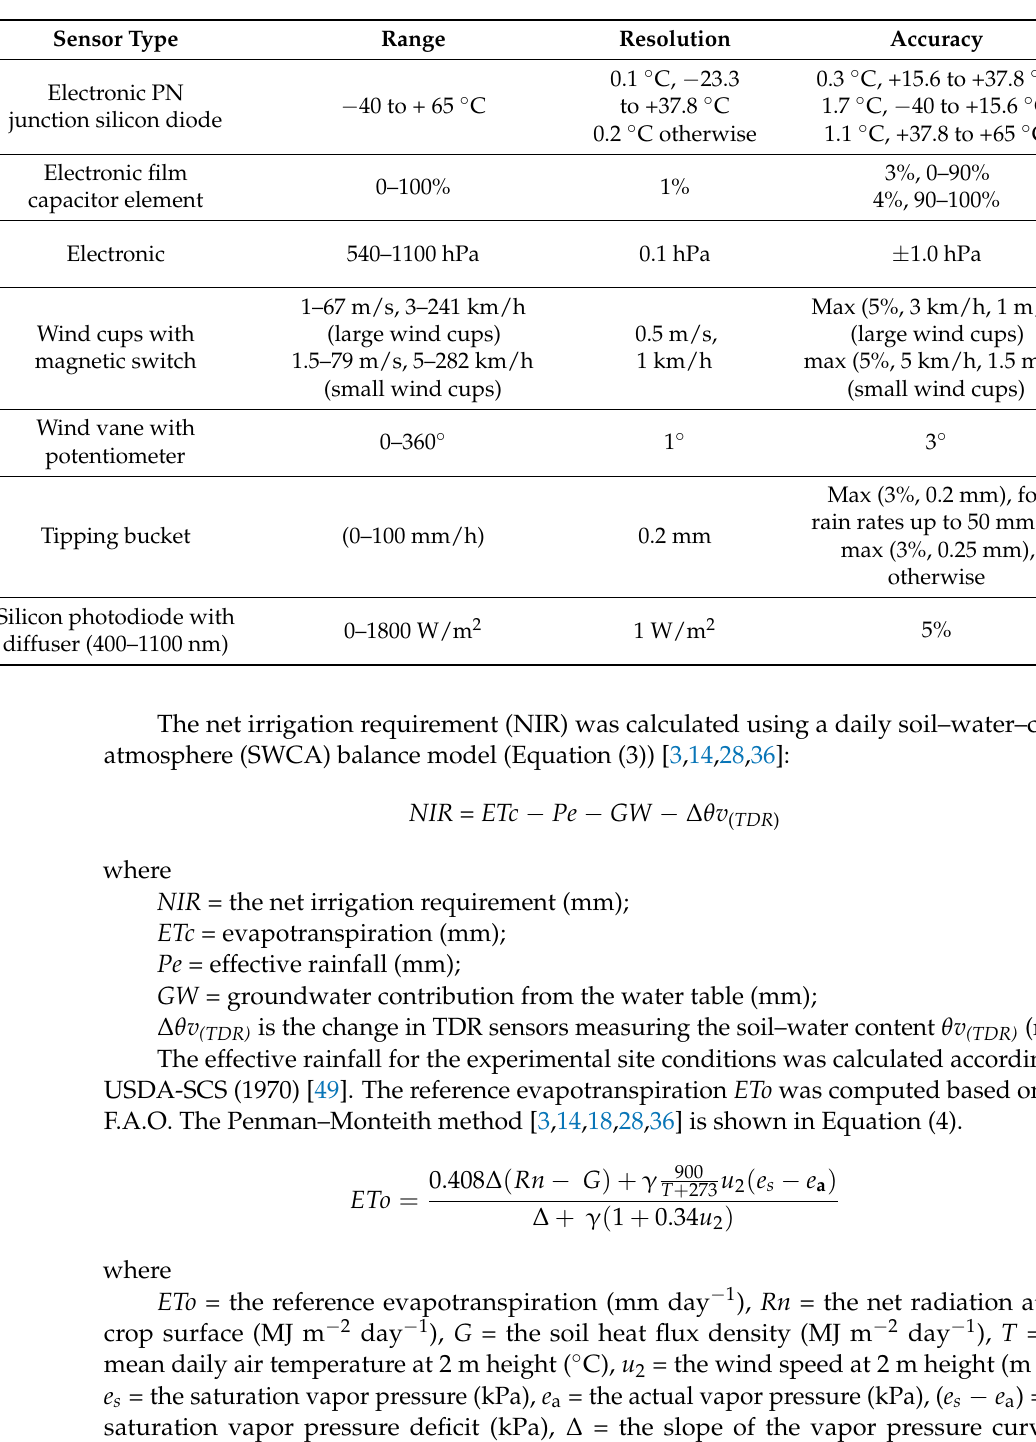
Table 1. The measured parameters and the technical characteristics of the weather